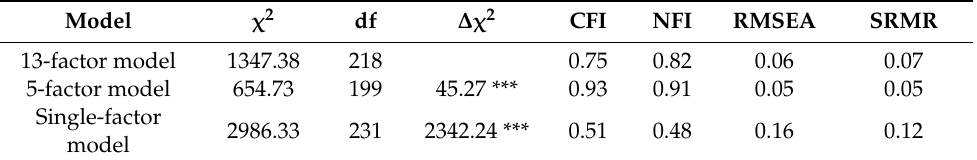
Table 2. Results of discriminative validity by